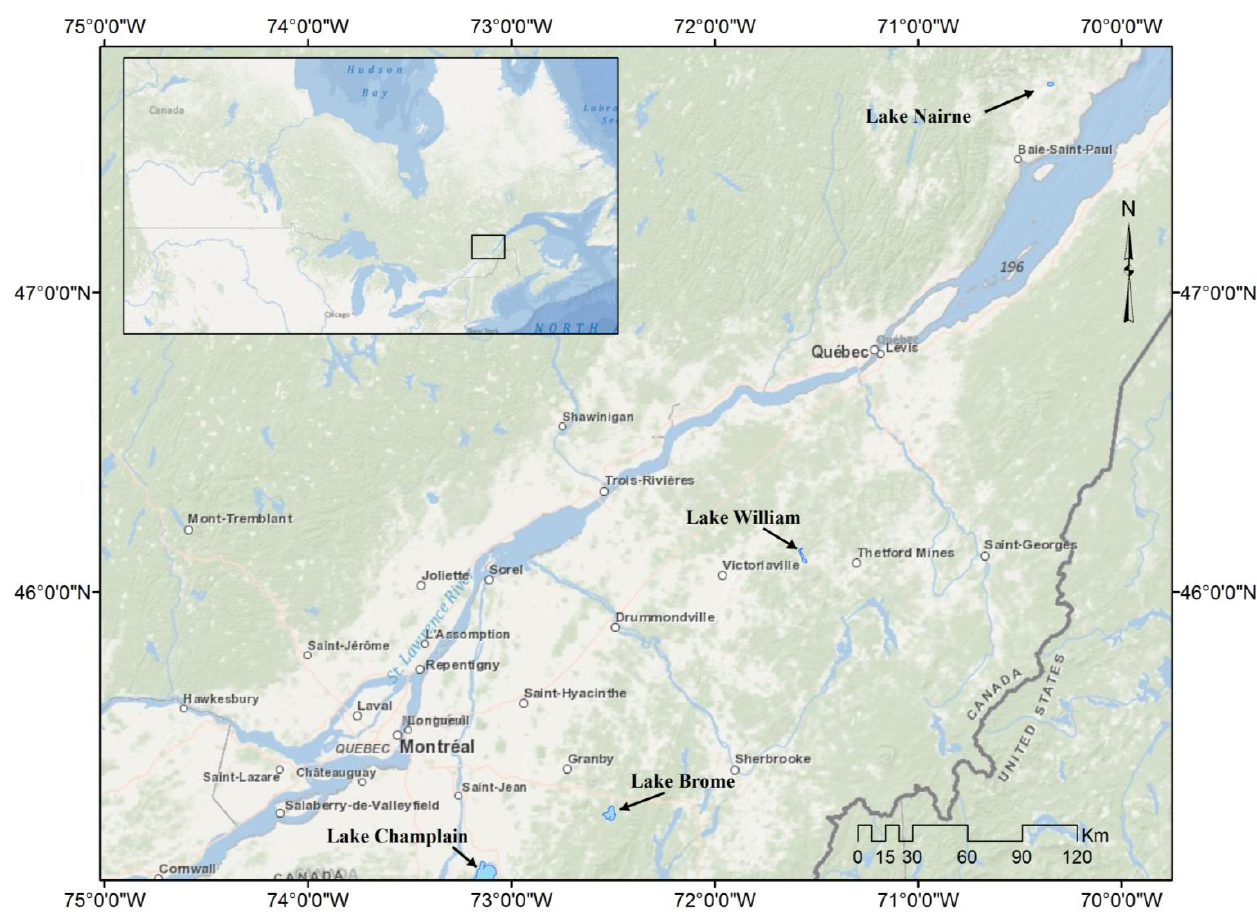
Figure 1. Geographic disposition of the studied